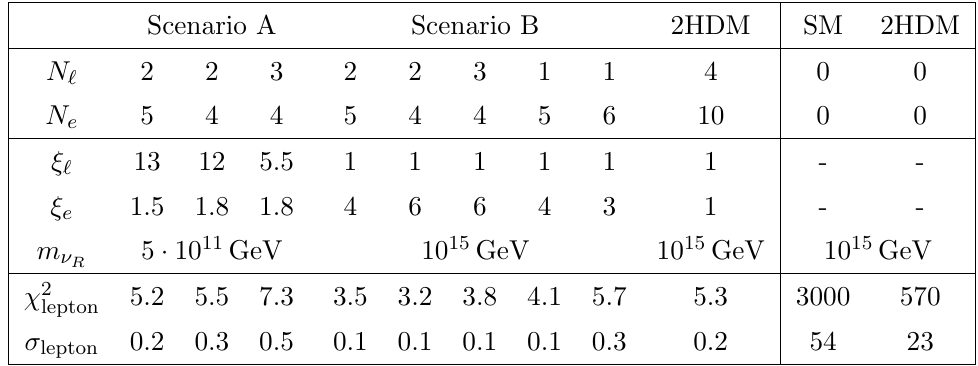
Table 2. Values of (cid:31) 2 for several choices of N ‘;e and (cid:24) ‘;e , and the seesaw scale m (cid:23) degrees of freedom involved in the computation of (cid:31) 2 are the three charged lepton masses, the three PMNS mixing angles and the Jarlskog invariant J . For the 2HDM we set tan (cid:12) = 40.